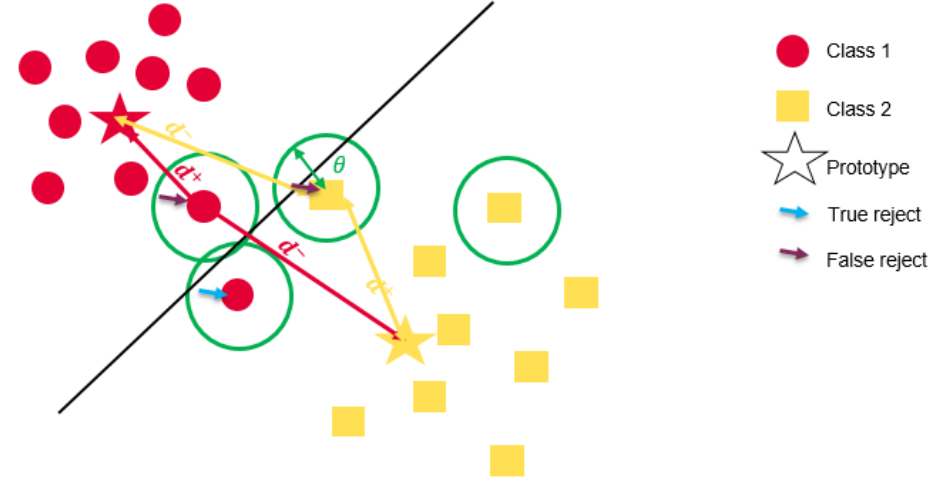
Figure 3. Prototype-based classification with reject criteria for a two classes problem. Each data point has a local reject decision depending on θ illustrated by the